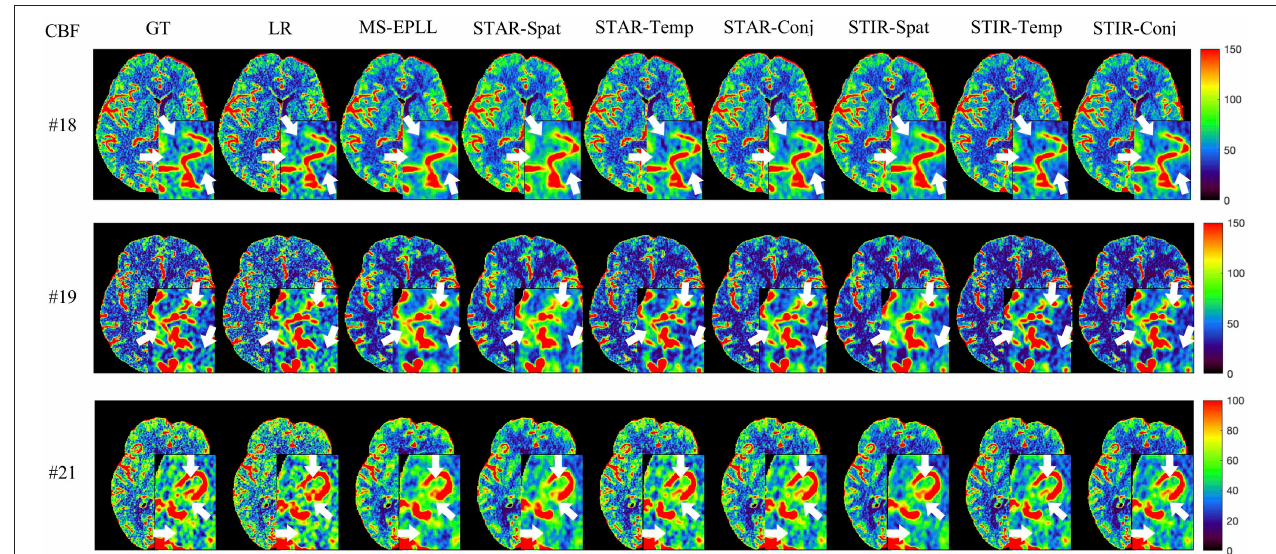
FIGURE 3 | Visual comparison of CBF for three test patients: #18, #19, and #21, when reducing the tube current to 40 mAs with a down-sample ratio of two (two times low spatial and two time low temporal resolutions). The notation for each column is: GT, Ground truth image; LR, Low-Resolution input; MS-EPLL, MS-EPLL restoration result; STAR-Spat, STAR reconstruction result (spatial only); STAR-Temp, STAR reconstruction result (temporal only); STAR-Conj, STAR reconstruction result (spatial + temporal); STIR-Spat, STIR-Net reconstruction result (spatial only); STIR-Temp, STIR-Net reconstruction result (temporal only); STIR-Conj, STIR-Net reconstruction result (spatial + temporal). All figures are displayed by using the same colormap and the color range for each patient is shown in the colorbar on the rightmost of each row. We use white arrows to compare the details in the region of interests.